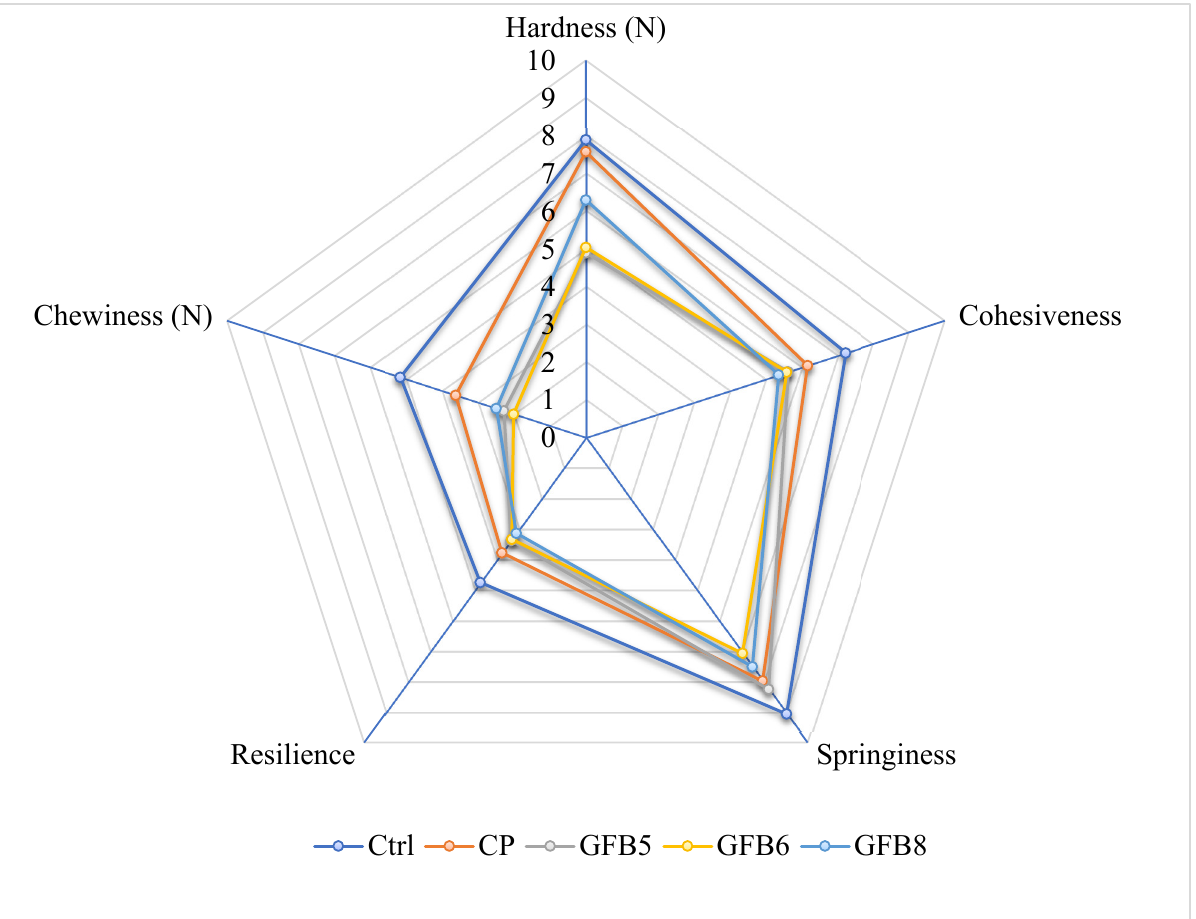
Figure 1. Mean values for texture parameters from the instrumental texture profile analysis. Bread formulations (batches): Ctrl, control batch; CP, control with protein added; GFB5, GFB6, and GFB8, gluten-free bread with protein and apple pomace powder added at 5%, 6% or 8%. Resilience, springiness and cohesiveness data must be read as × 10 − 1